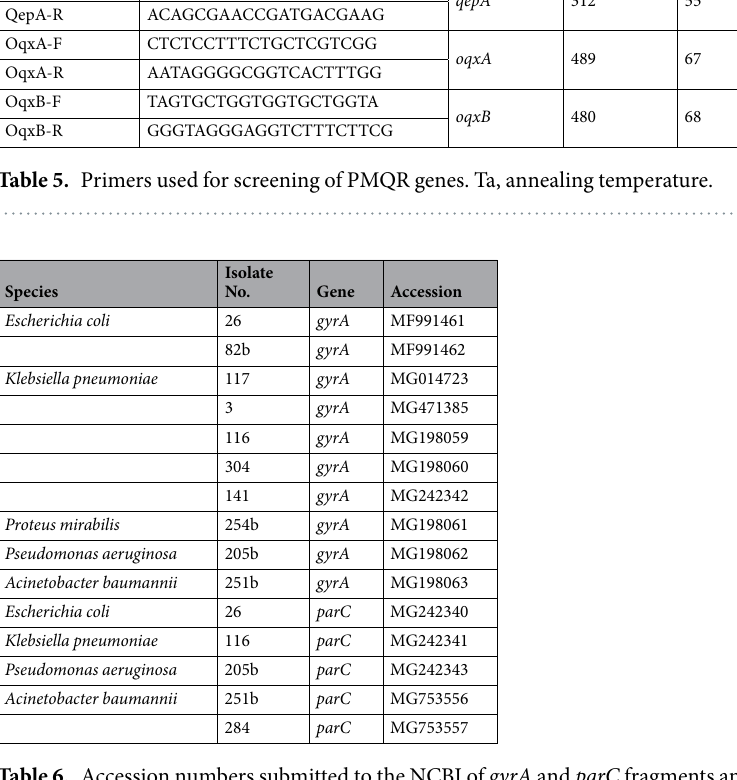
Table 6. Accession numbers submitted to the NCBI of gyrA and parC fragments amplified from different isolates of various